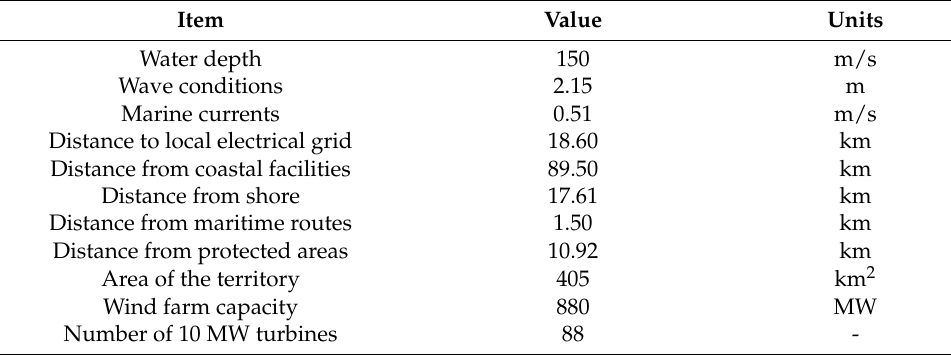
Table 2. Main characteristics of the Ribadeo floating wind